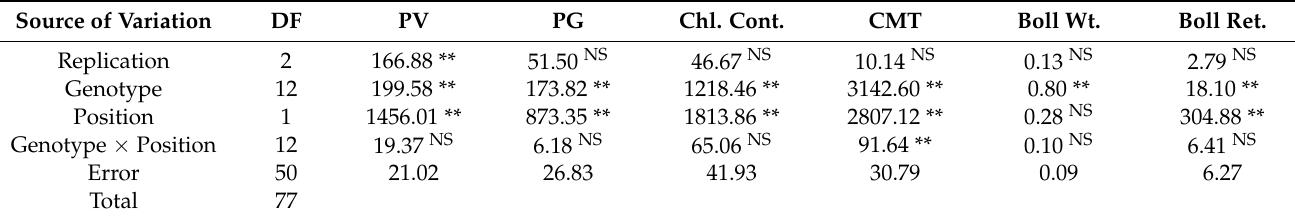
Table 3. Mean squares for six measures of heat tolerance in cotton grown under field conditions.